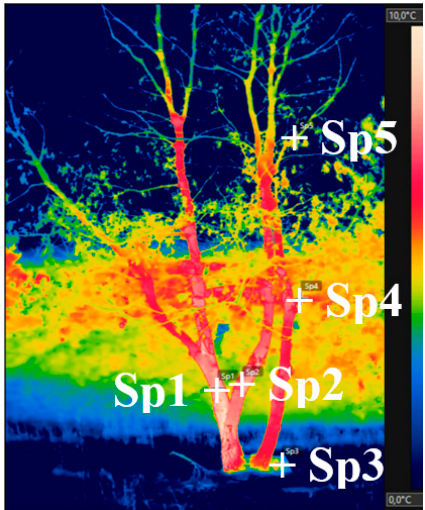
Figure 7. Thermogram of the Quercus pyrenaica Willd tree taken at 9:45 p.m., 4 h after sunset. (Spot’s size out of scale for better visualization). Table 3. The ambient conditions and parameters for the thermograms of Quercus pyrenaica (Figures 6 and 7).